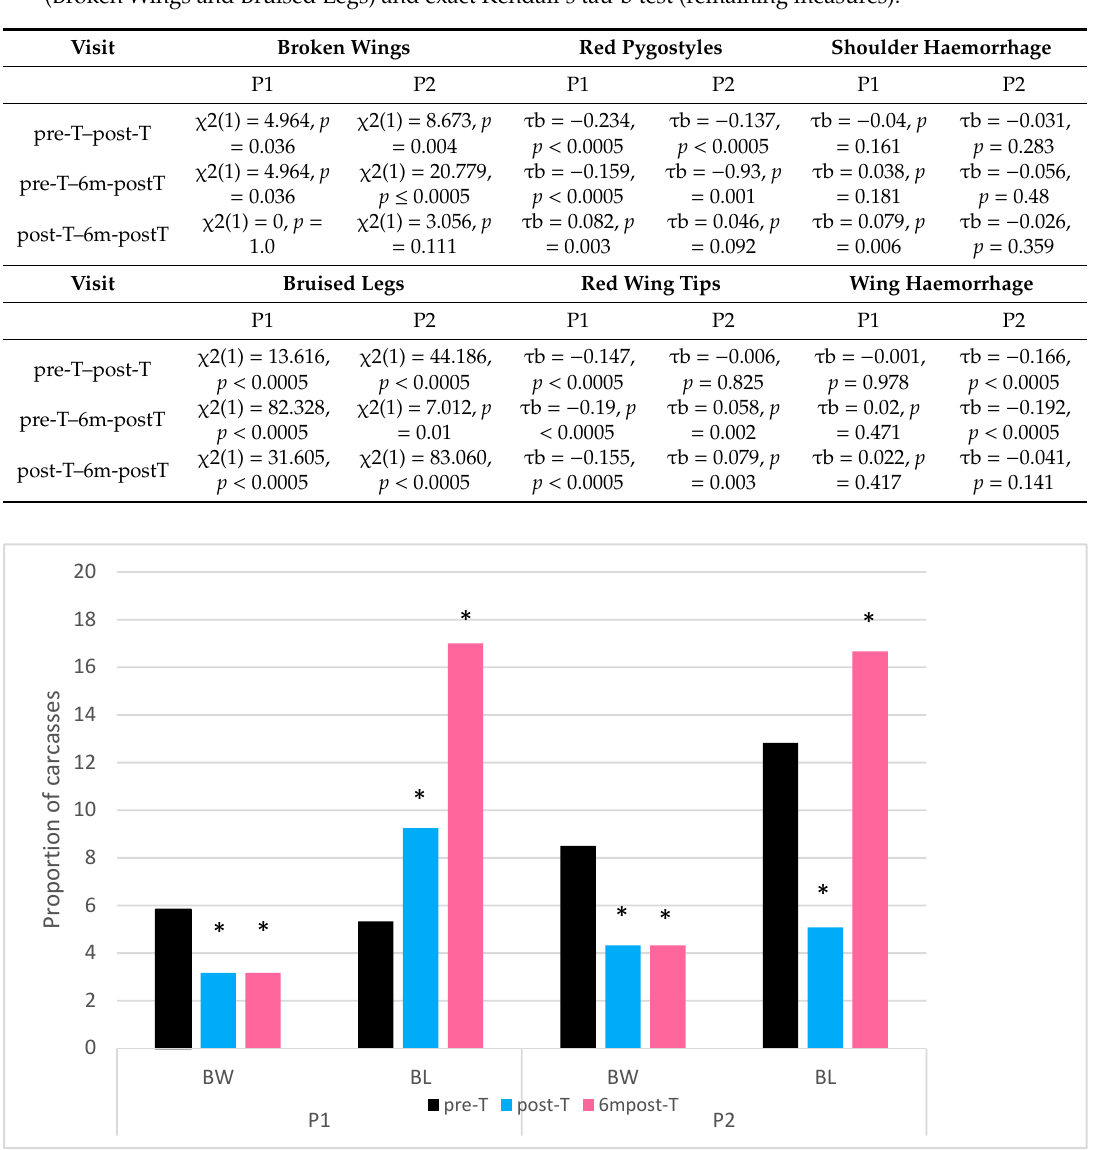
Table 6. The test of association between the measurements and visits for the exact Chi-square test (Broken Wings and Bruised Legs) and exact Kendall’s tau-b test (remaining measures).